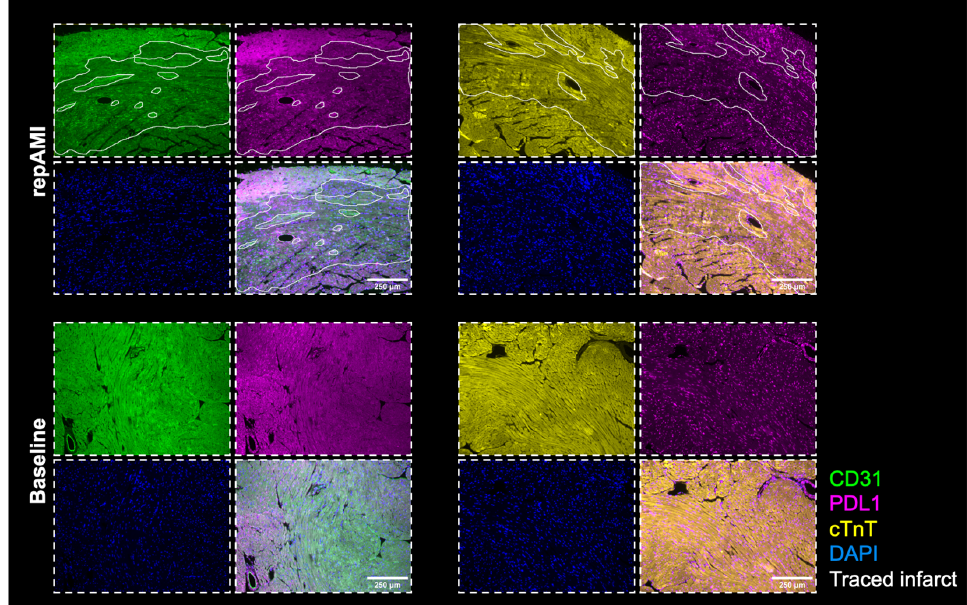
Figure 3. PDL1 distribution at baseline and following repAMI. Representative data from immunofluorescence imaging in mouse hearts 24 h following repAMI. PDL1 is shown in magenta, the endothelial cell marker CD31 in green, cardiac troponin T in yellow, and nuclei in blue. Imaging shows decreased PDL1 expression in the infarct zone which is identified by a decrease in CD31 expression and a decrease in cardiac troponin T.